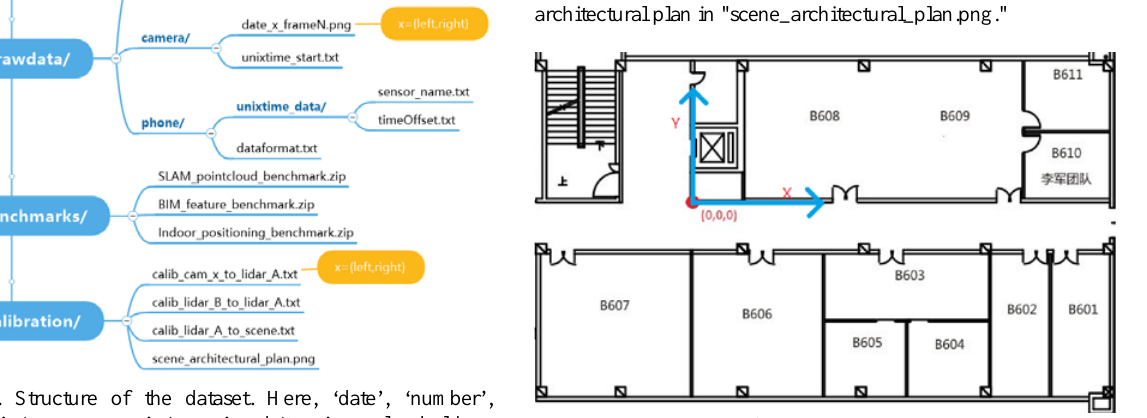
Figure 3. An example of a scene's architectural plan, the red dot on the picture is the origin we select, which is on the ground. Also, the blue arrows point the direction of X-axis and